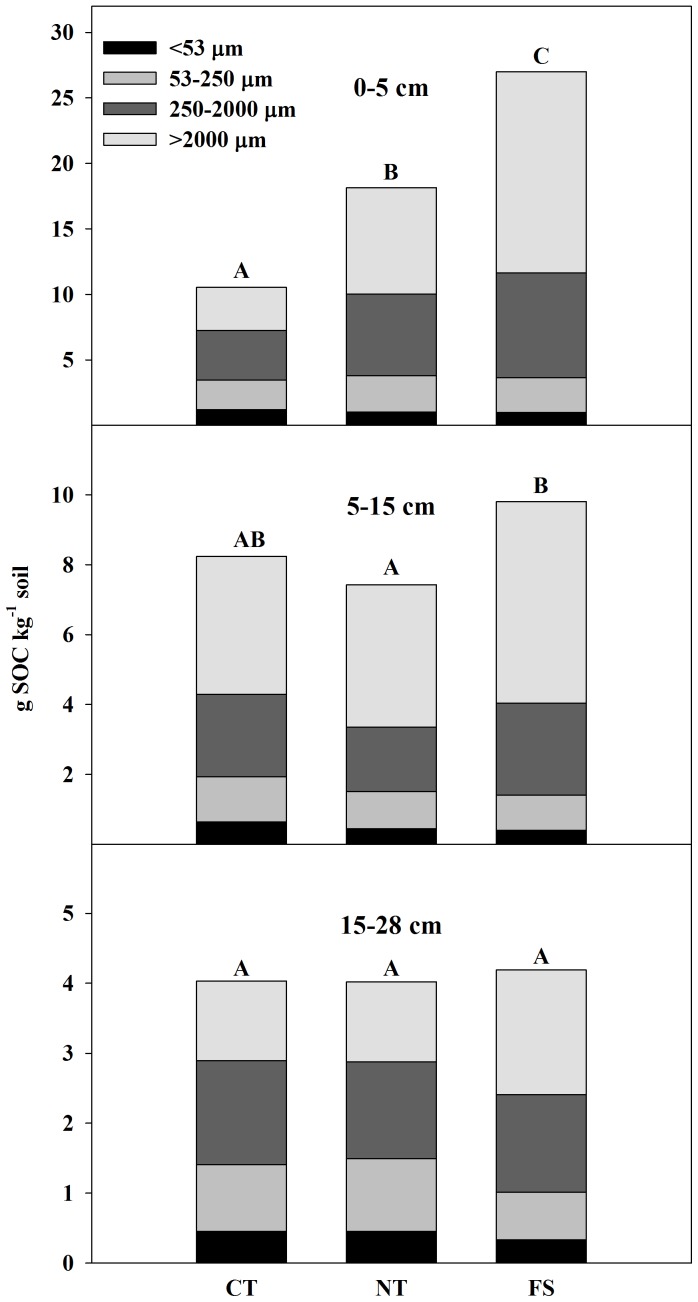
Contributions of four different aggregate size fractions to total soil organic C (SOC) concentrations.Different letters indicate a significant difference between land uses in a depth class (α = 0.05). Means of the sums of the four fractions are shown (n = 4) from Horseshoe Bend, Athens, GA, USA, October 2007. See also Table S6.